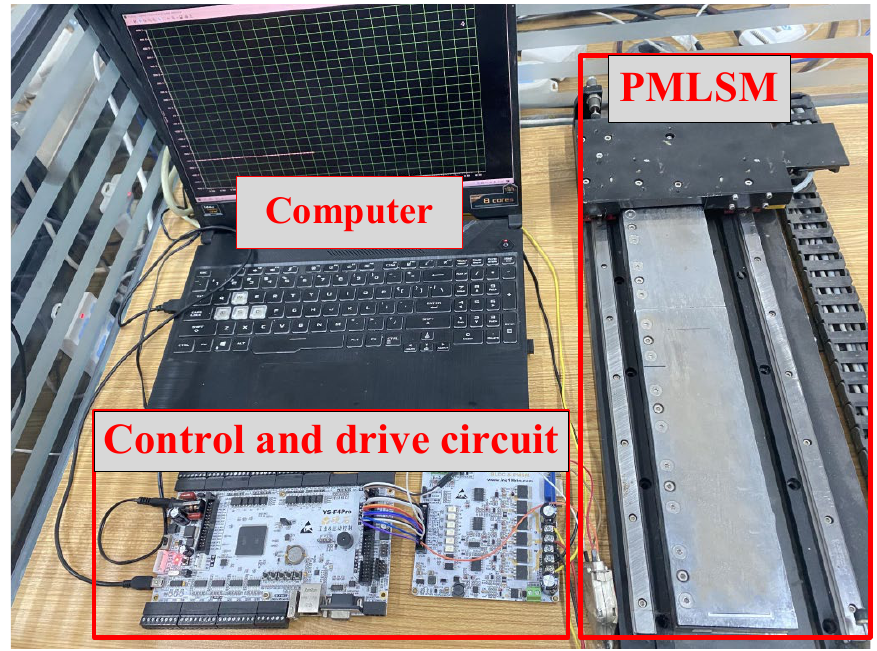
Figure 13. Experimental diagram.